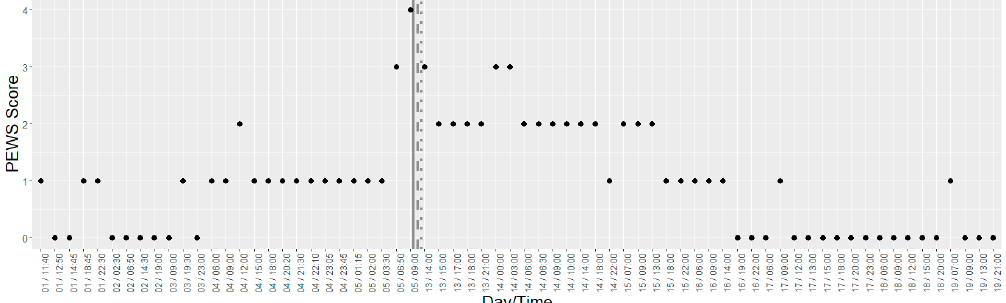
Figure 2. Pediatric Early Warning Score (PEWS) before and after PICU. The solid line denotes transfer to PICU + intubation, the dashed line denotes extubation, and the dotted line denotes discharge from PICU.